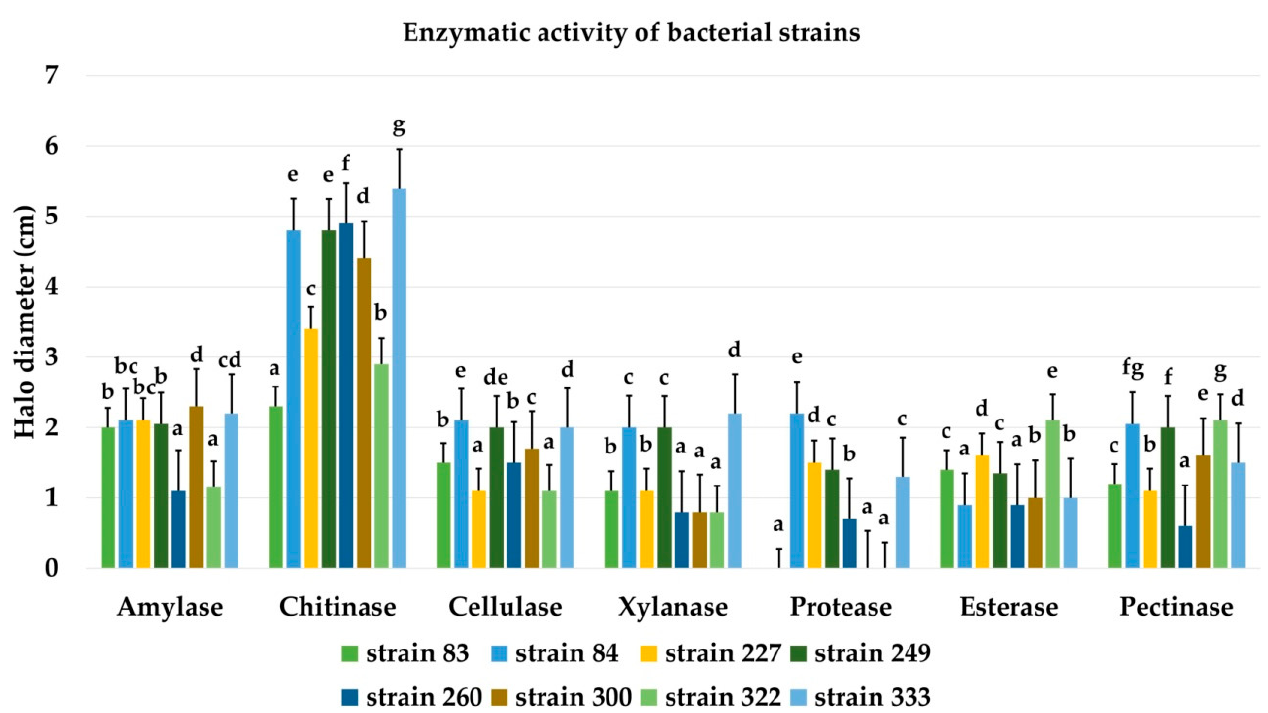
Figure 13. Production of hydrolytic enzymes by bacterial strains. The data present the means ± the standard error. Different letters between bars in each group indicate a significant difference at ( p < 0.05) determined by ANOVA with the comparison of means using Tukey’s HSD.